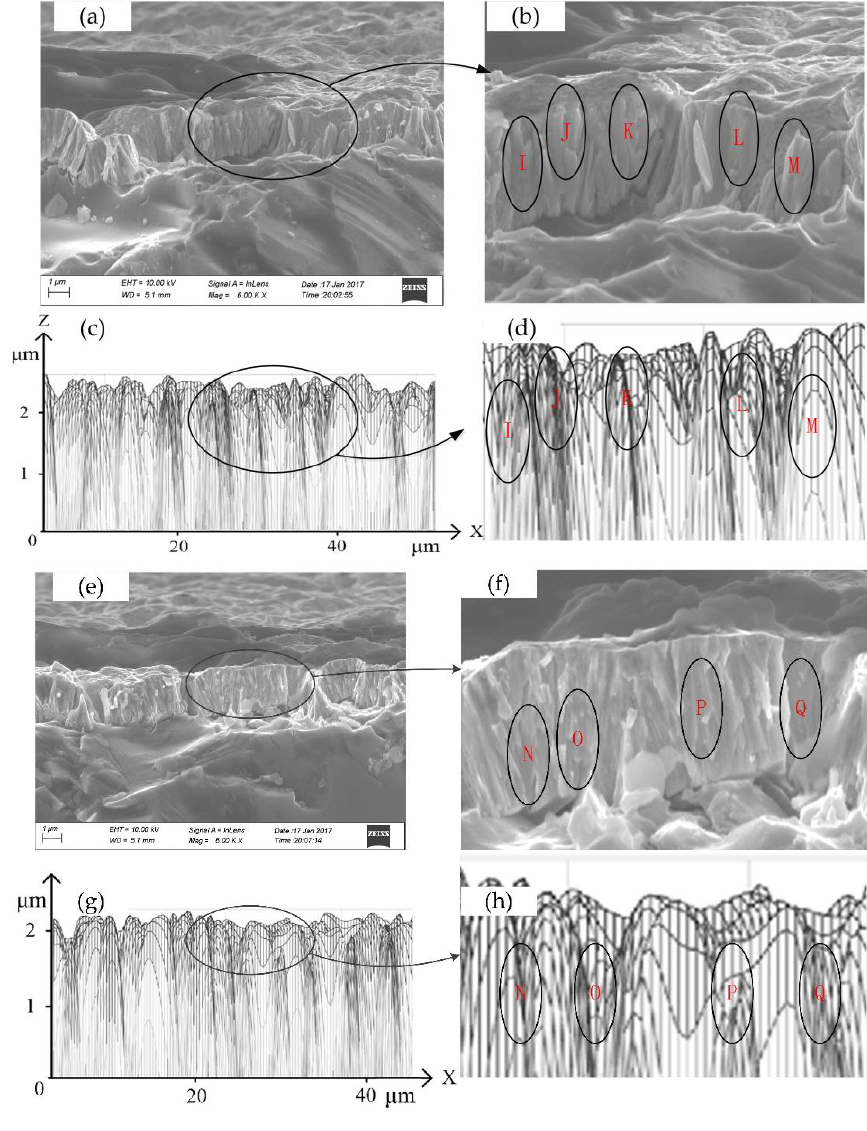
Figure 10. Simulated and experimental real topography. ( a ) Cross-section of experimental real topography, ( c ) cross-section of simulation, ( b ) a local enlarged view of ( a ), ( d ) a local enlarged view of ( c ), ( e ) cross-section of experimental real topography, ( g ) cross-section of simulation, ( f ) a local enlarged view of ( e ); ( h ) a local enlarged view of ( g ).